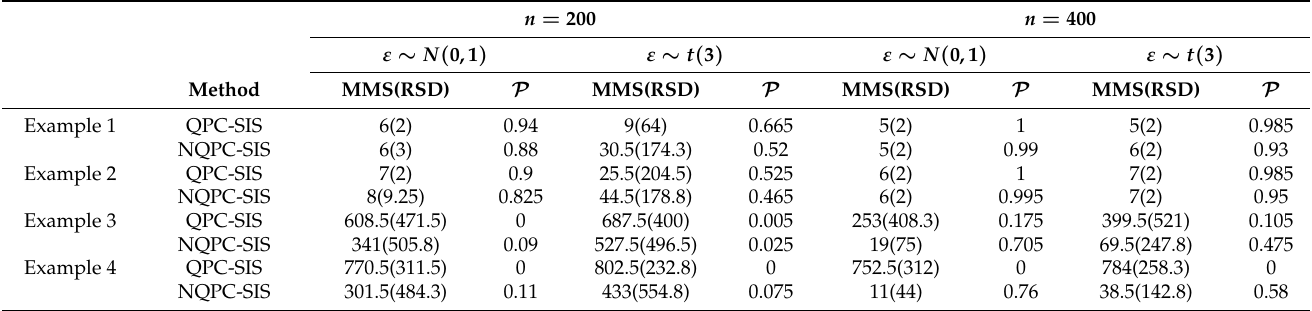
Table 5. Simulation results for Examples 1 to 4 when ρ = 0.9 and τ = 0.5. n = 200 n = 400 ε ∼ N ( 0,1 ) ε ∼ t ( 3 ) ε ∼ N ( 0,1 ) ε ∼ t ( 3